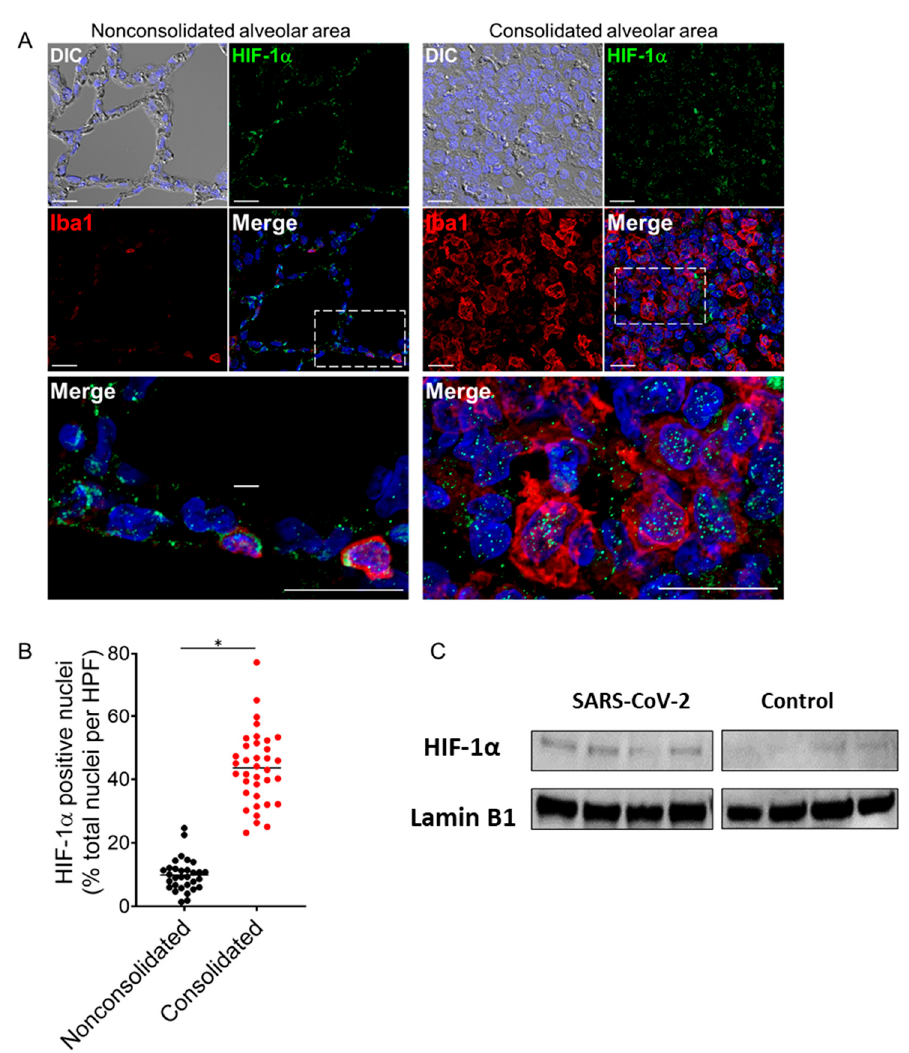
Figure 2. Activation of HIF-1 α in lung monocytes/macrophages of infected hamsters. ( A ) Double immunofluorescence imaging of HIF-1 α and Iba1 (monocyte/macrophage marker) in lung sections from a SARS-CoV-2-infected hamster at 4 dpi. Prominent HIF-1 α staining localizes to the nuclei of Iba1-positive monocytes/macrophages that accumulate in areas of lung consolidation. Minimal nu- clear HIF-1 α expression is observed in nonconsolidated lung regions with normal alveolar architec- ture. Nuclei were counterstained with Hoechst 33342 (blue). Scale bars: 20 µm. ( B ) Semiquantitative analysis of HIF-1 α expression in consolidated and nonconsolidated regions of SARS-CoV-2-infected lungs at 4 dpi. A total of 8–10 high power fields (HPFs) from consolidated and nonconsolidated regions were analyzed per lung section for each infected animal ( n = 4). Plotted values represent the percent positive HIF-1a nuclei as a function of total nuclei for each HPF. * p < 0.05, Mann–Whitney test. ( C ) Immunoblotting showing HIF-1 α expression in nuclear extracts from lung tissue lysates of SARS-CoV-2-infected and non-infected hamsters (upper panel) and Lamin B1 as loading control (lower panel). Densitometric analysis for relative expression of HIF-1a was done by BioRad Image Lab 5.2.1 software (Supplementary Figure S3). DIC = differential interference contrast. To examine whether the increased nuclear expression of HIF-1 α correlates with the activation of HIF-1 α transcriptional pathways, we analyzed the expression of key glyco- lytic HIF-1 α target proteins including Glut1, LDH, and PDK1 by immunofluorescence and immunoblot. Immunofluorescence analyses revealed that the monocyte/macrophage population that expressed nuclear HIF-1 α in regions of consolidation also expressed high levels of membrane associated Glut1, whole cell LDH, and mitochondrial-associated PDK1 (Figure 3A, Supplementary Figure S2). Higher levels of Glut-1 and PDK1 were also